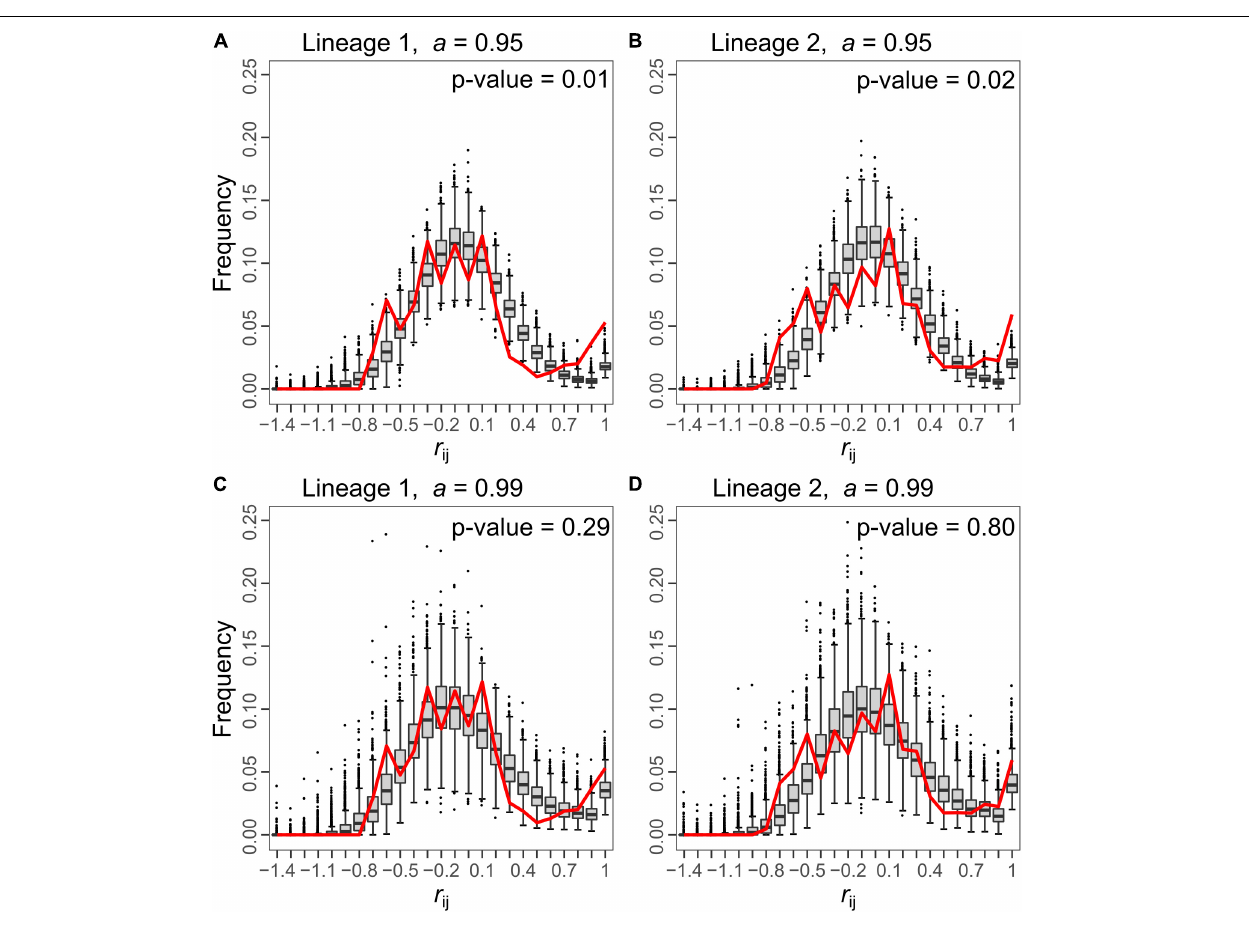
FIGURE 4 | Comparison of the distributions of relationship coefficient ( r ij ) between all pairs of queens from the simulated (box-and-whisker plots) and from the empirical (red line) data for both lineages. For each lineage, two rates of automixis are represented for the simulated data: a = 0.95 (A,B) and 0.99 (C,D) . In all plots, simulations were generated with a population size, N , of 250 and no migration ( m = 0). Under a = 0.95, the distribution of the simulated r ij deviates from the bimodal empirical distribution (p-values = 0.01 and 0.02 for lineage 1 and 2, respectively), while a better fit is obtained for a = 0.99 (p-values = 0.29 and 0.80 for lineage 1 and 2, respectively). Each box-and-whisker plot represents the distribution of proportions of simulated r ij values falling in a given bin among simulated datasets. The bottom and top of the box are the 25 th and 75 th percentiles, respectively, and the band within the box is the 50 th percentile (the median). Values falling outside the box range (i.e., the range between the 25 th and the 75 th percentiles) are represented by the whiskers. The upper (lower) limit of the whisker corresponds to the most extreme value within the range of the 75 th (25 th ) percentile + (–) 1.5 × the box range. Beyond these limits, outliers are represented by black dots. The x-axis indicates the upper bound of each